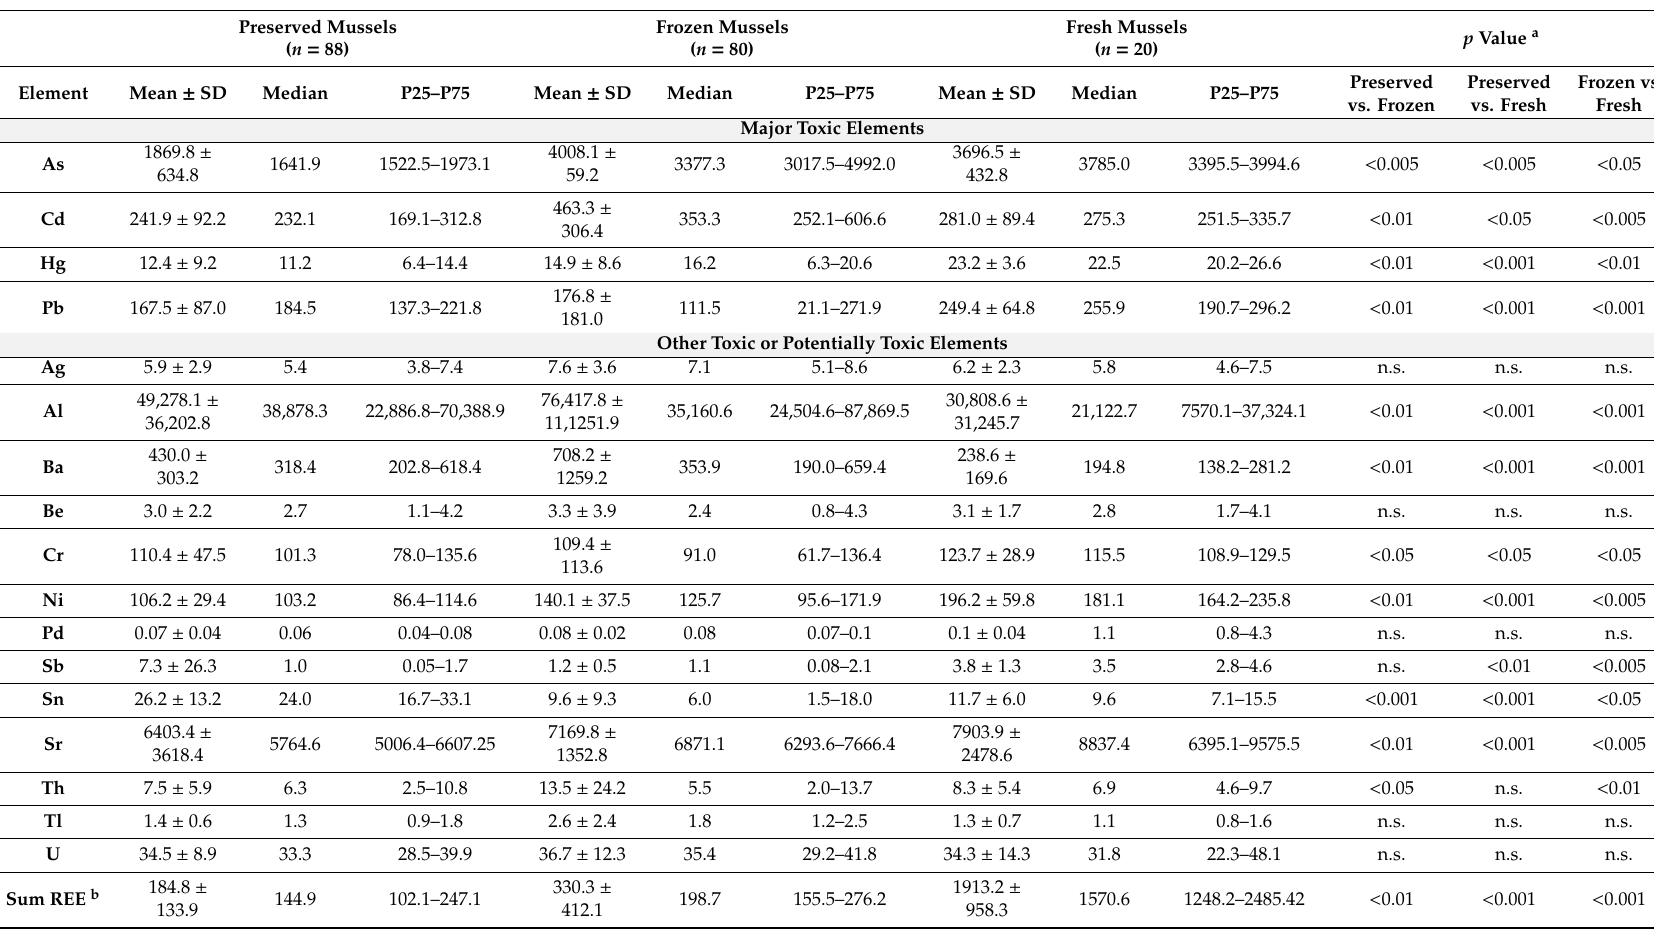
Table 3. Concentrations of toxic elements in mussels from di ff erent types of conservation in the Spanish market. Results are expressed in ng /